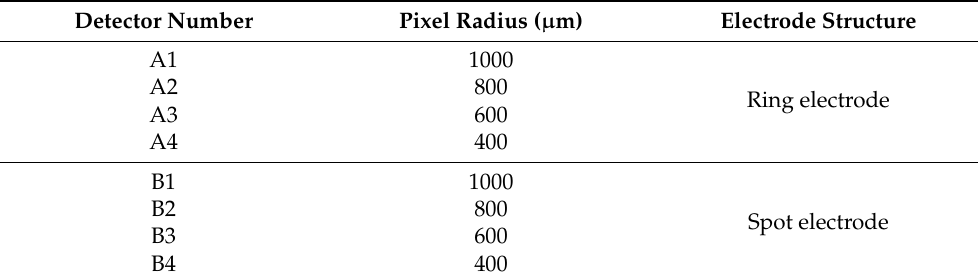
Table 1. Detector number and the corresponding